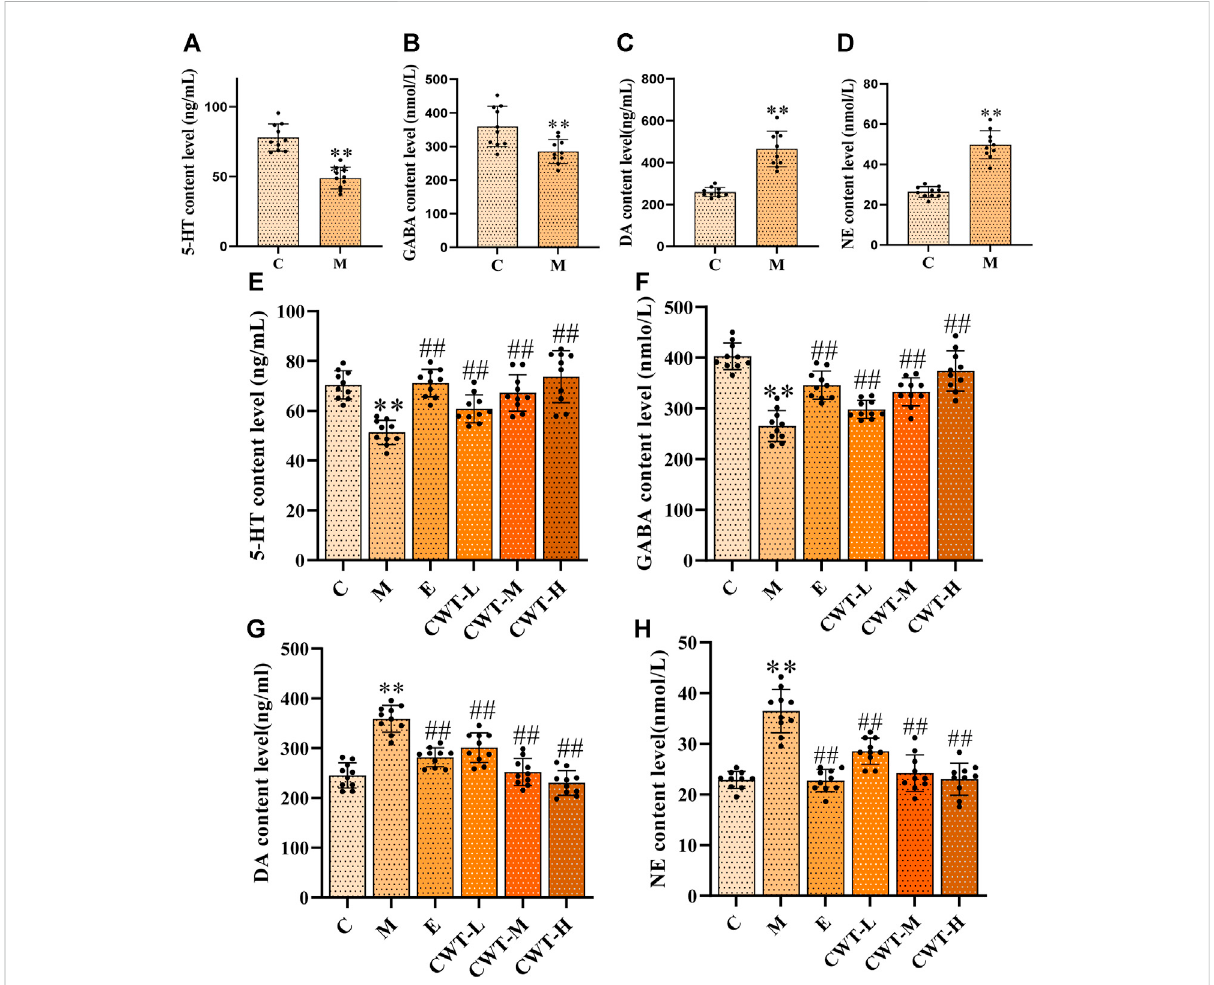
FIGURE 9 Neurotransmitter content in the brain (C: control group, n = 10; M: model group, n = 10; E: estazolam group, n = 10; CWT-L group, n = 10; CWT-M group, n = 10; CWT-H group, n =10; compared with thegroup C, * p < 0.05, ** p < 0.01; comparedwith thegroup M, # p < 0.05, ## p < 0.01, mean ± SD). Figures (A – D) : Test results on the fourth day of insomnia model establishment; Figures (E – H) : Test results on the seventh day of treatment. (A) :5-HT content analysis ingroups Cand M. (B) :GABAcontentanalysis ingroupsC andM. (C) :NE content analysisingroupsC